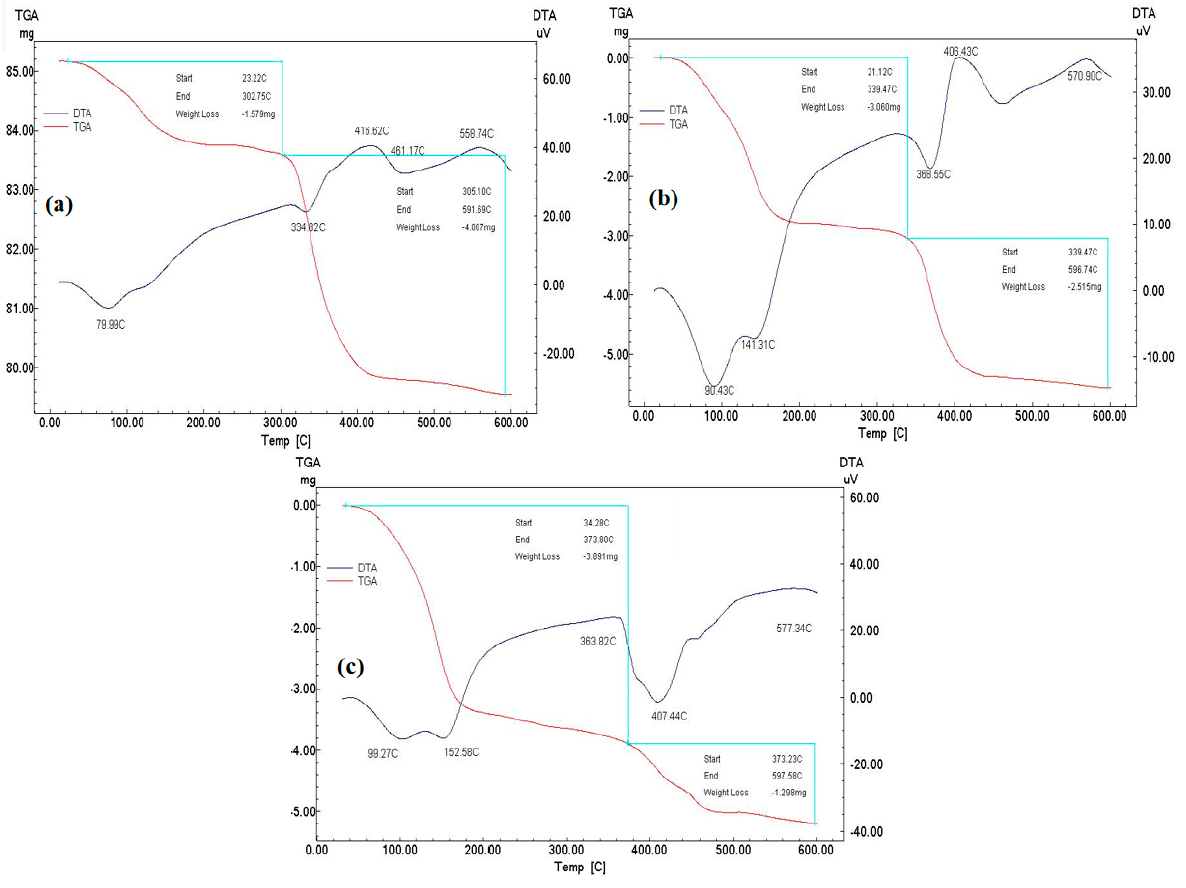
Figure 4. TGA and DTA curves of ( a ) NIP ( b ) MIP and ( c ) GO-MIP .